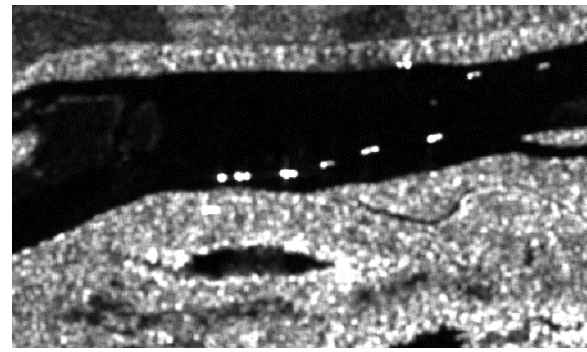
Figure 15. Vessel situation (2) - Zimnicea – 09.08.2015 -